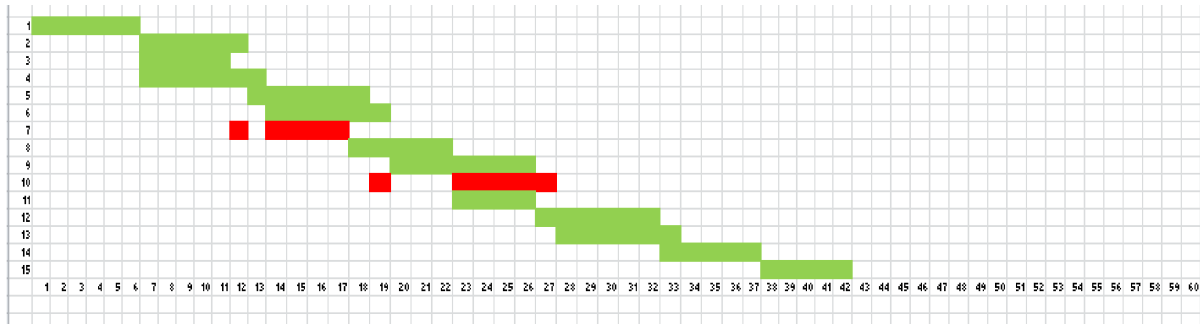
Figure 9. Gantt chart of the 4th experiment after using the proposed method